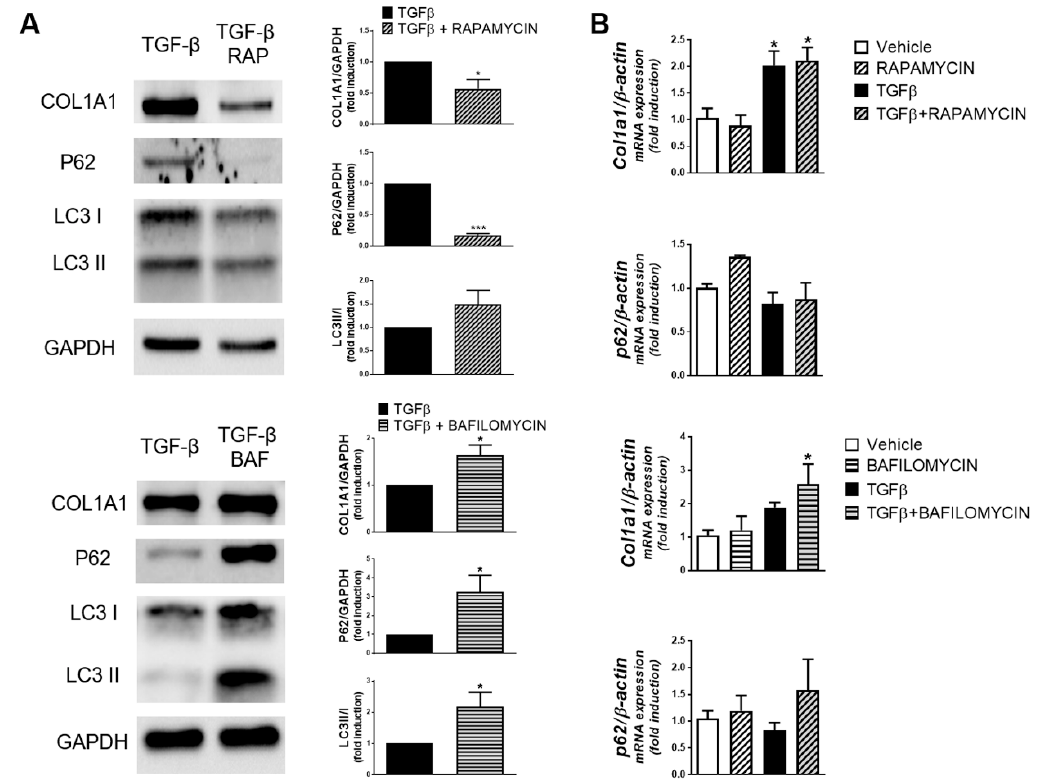
Figure 3. Human primary fibroblasts isolated from the healthy margin of intestinal carcinoma resections ( n = 5) were treated with TGF- β (5 ng/ml), in the presence of Rapamycin (50 nM), Bafilomycin B1 (10 nM) or their vehicles, for 24 hours. ( A ) Representative Western blots and protein levels of Col1a1, P62, LC3-I/II and GAPDH; and ( B ) graphs showing Col1a1 and P62 mRNA expression (results normalized with β -actin and represented as fold induction vs. vehicle-treated cells). Bars in graphs represent mean±S.E.M. Significant differences vs. vehicle-treated fibroblasts are shown by * p < 0.05, and *** p < 0.001; as analyzed by ANOVA with a Newman–Keuls post hoc correction for multiple comparisons or a t -test when appropriate (Graph-Pad Software v6.0).